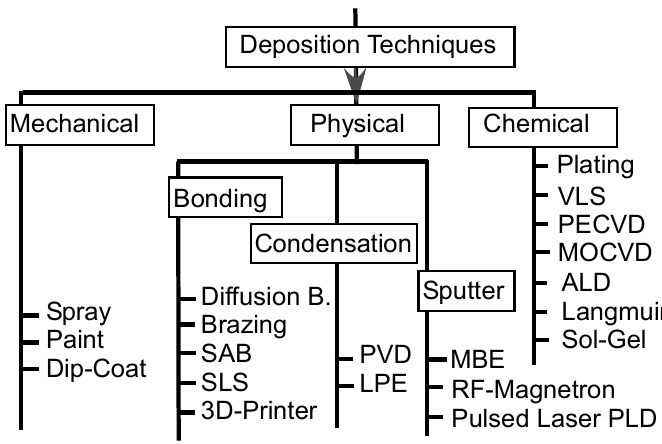
Figure 1. Categorization of several deposition techniques for thin film deposition or